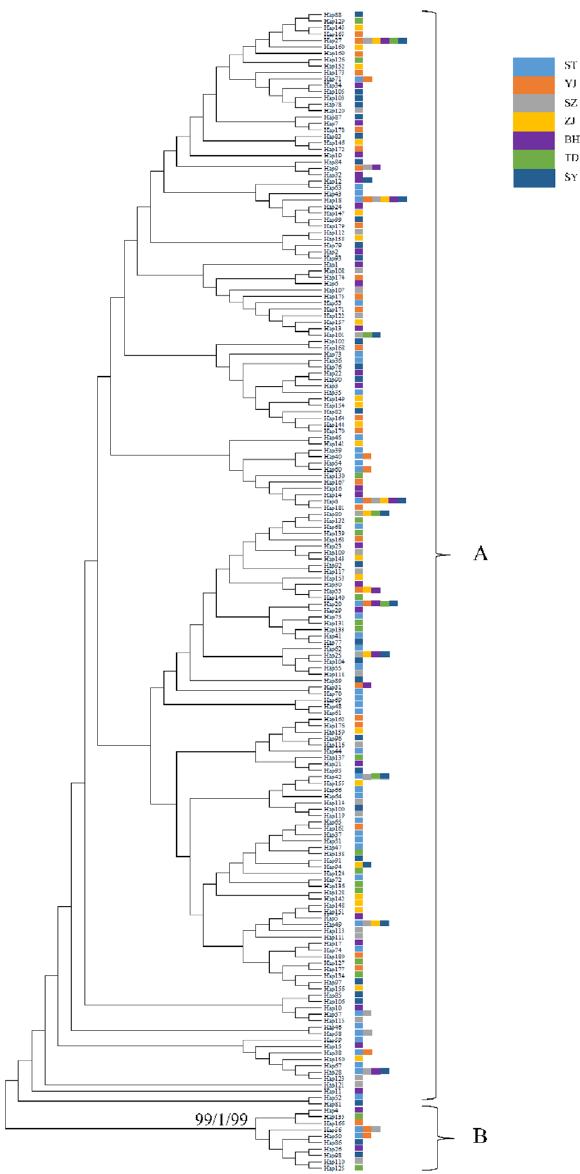
Figure 2. Phylogenetic trees reconstructed from mitochondrial sequences of the cyt b gene in Trichiurus nanhaiensis . The values above the branches are bootstrap values for the NJ, BI, and ML